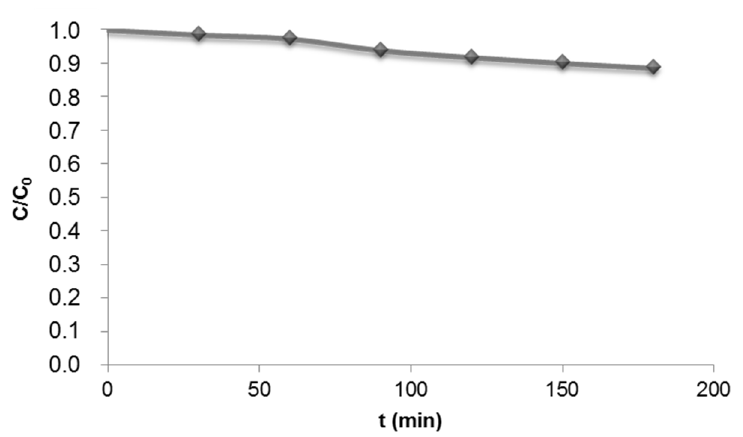
Figure 3. DR73 degradation after 180 min of UV irradiation ( λ = 365